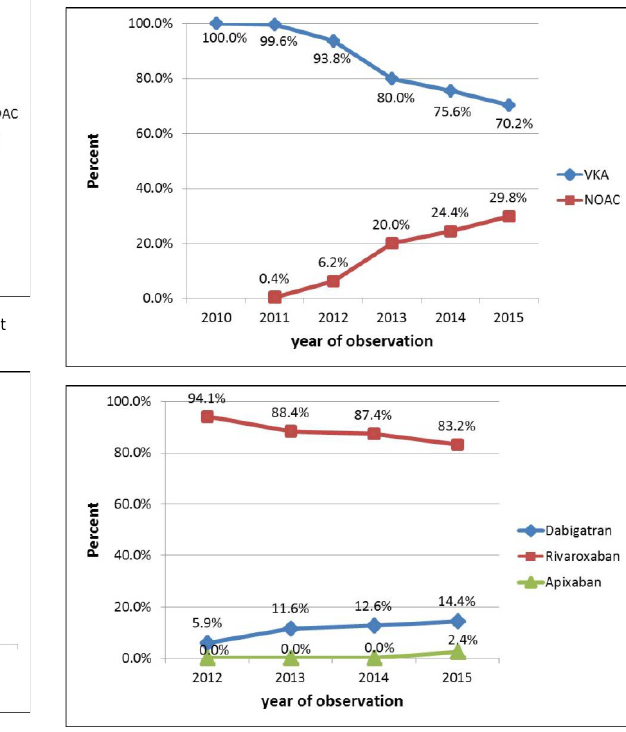
Figure 3: Prevalence of oral anticoagulated patients over time from 2010 to 2015; 203 patients with CHA 2 DS 2 -VaSc score of 0 (men) or 1 (women) were excluded from the analyses.